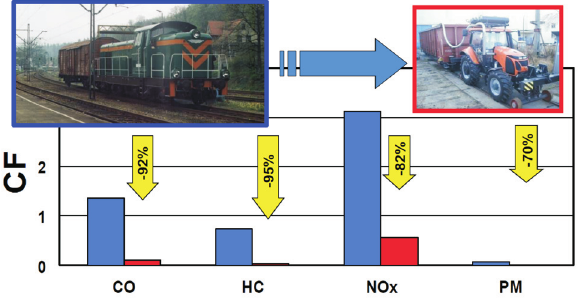
Fig. 18. Replacement of diesel locomotives with light railcars